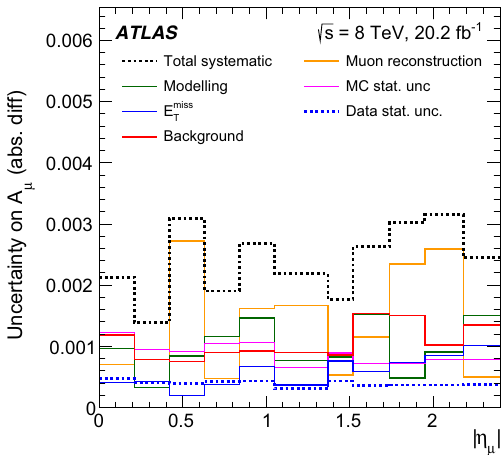
Fig. 3 The systematic uncertainty from each source for the W boson chargeasymmetryasanabsolutedifferencefromthecentralvalue.Also shown are the total systematic and statistical uncertainties